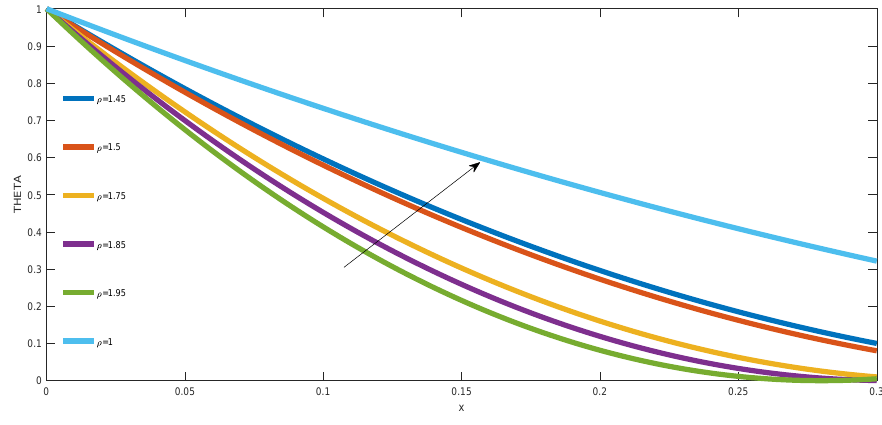
Figure 2. Solution of Equation (12) when ϕ = 1 and ρ ≥ 1.